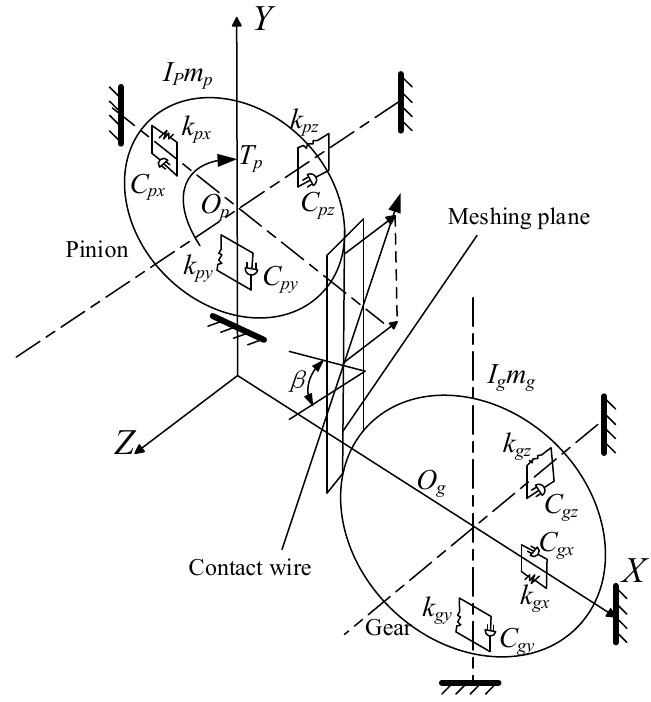
Figure 1. Nonlinear dynamic model of cylindrical helical gear transmission.